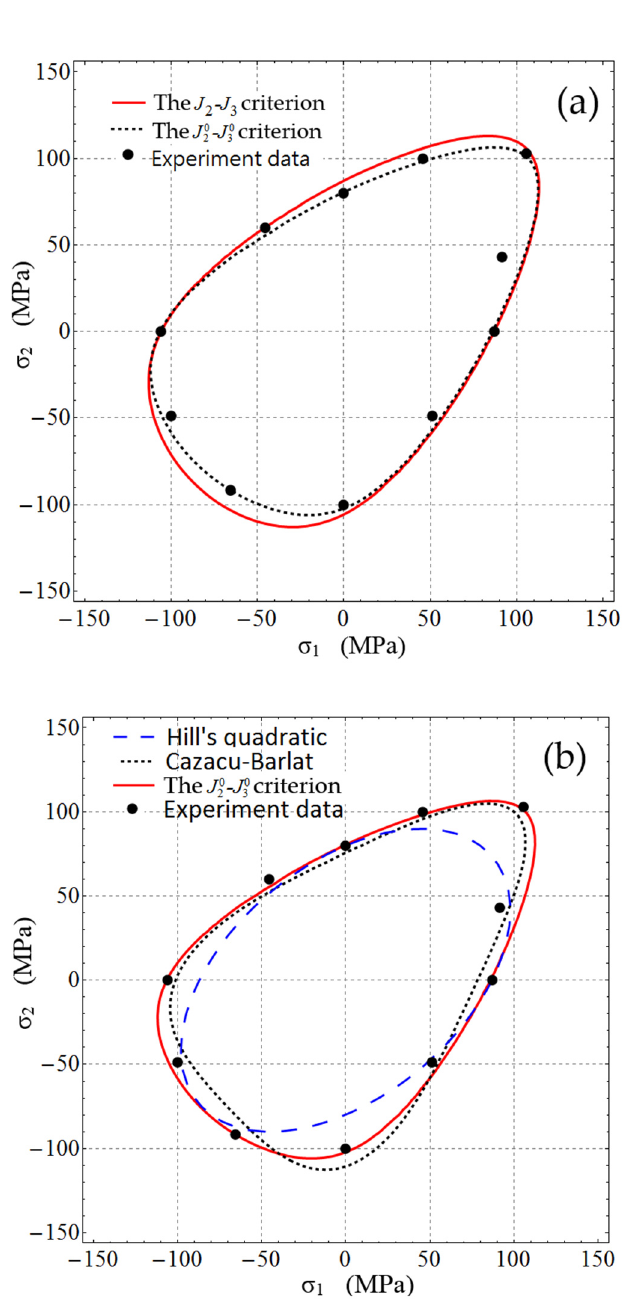
Figure 4. Comparison of experimental results and the theoretical initial transformation onset surfaces for Cu-Al-Be SMA in the ( σ 1 , σ 2 ) plane predicted by yield criteria: ( a ) the J 2 - J 3 criterion and the J 0 criterion; ( b ) the J 0 - J 0 criterion, Hill’s quadratic criterion and the Cazacu–Barlat criterion. In order to compare the J 0 - J 0 criterion with existing theories in the literature, the 2 3 yield locus of the J 0 - J 0 criterion, Hill’s quadratic criterion [31] and the Cazacu–Barlat 2 3